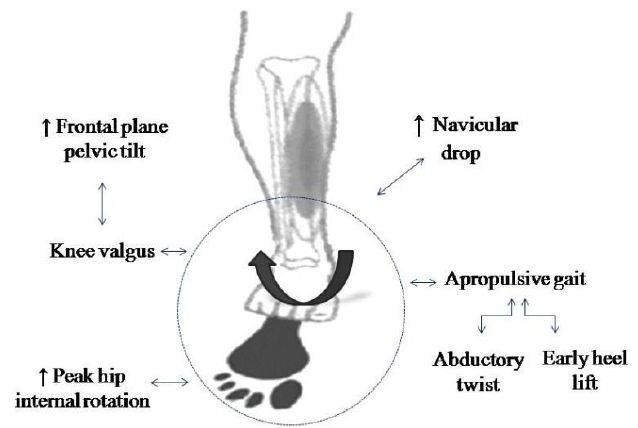
Figure 2. Factors commonly associated with foot overpronation.